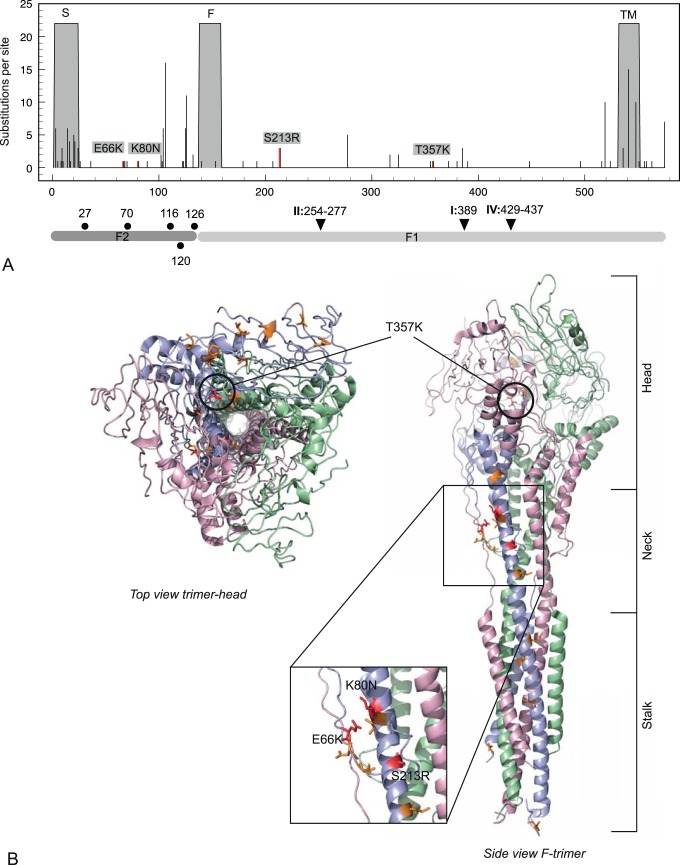
Amino acid substitutions in specific domains of the RSV F protein.A) Indicated are the signal peptide (S), fusion peptide (F), transmembrane domain (TM), F1 and F2 domains, antigenic sites I, II and IV (black triangles), and N-glycosylation sites (black dots). B) Substitutions marked in the 3D structure of the trimeric fusion protein. Amino acid class changes are indicated in red, orange indicating similar class.